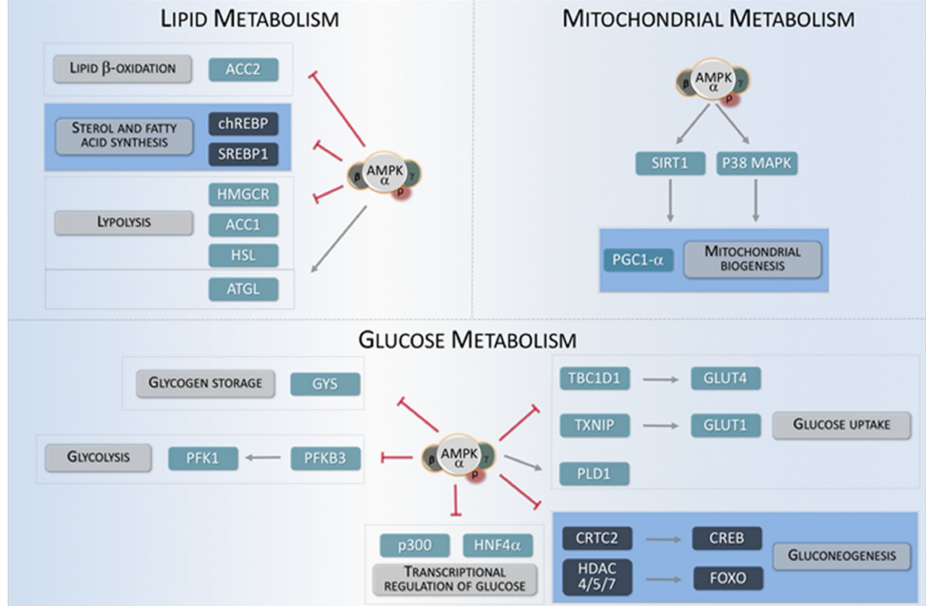
Figure 2. AMPK regulates different metabolic key targets. The metabolic pathways modulated by AMPK can be classified into three general categories: Lipid metabolism, mitochondrial metabolism, and glucose metabolism. The arrow indicates key targets for AMPK involved in these three metabolic categories. Transcriptional regulators are shown in dark